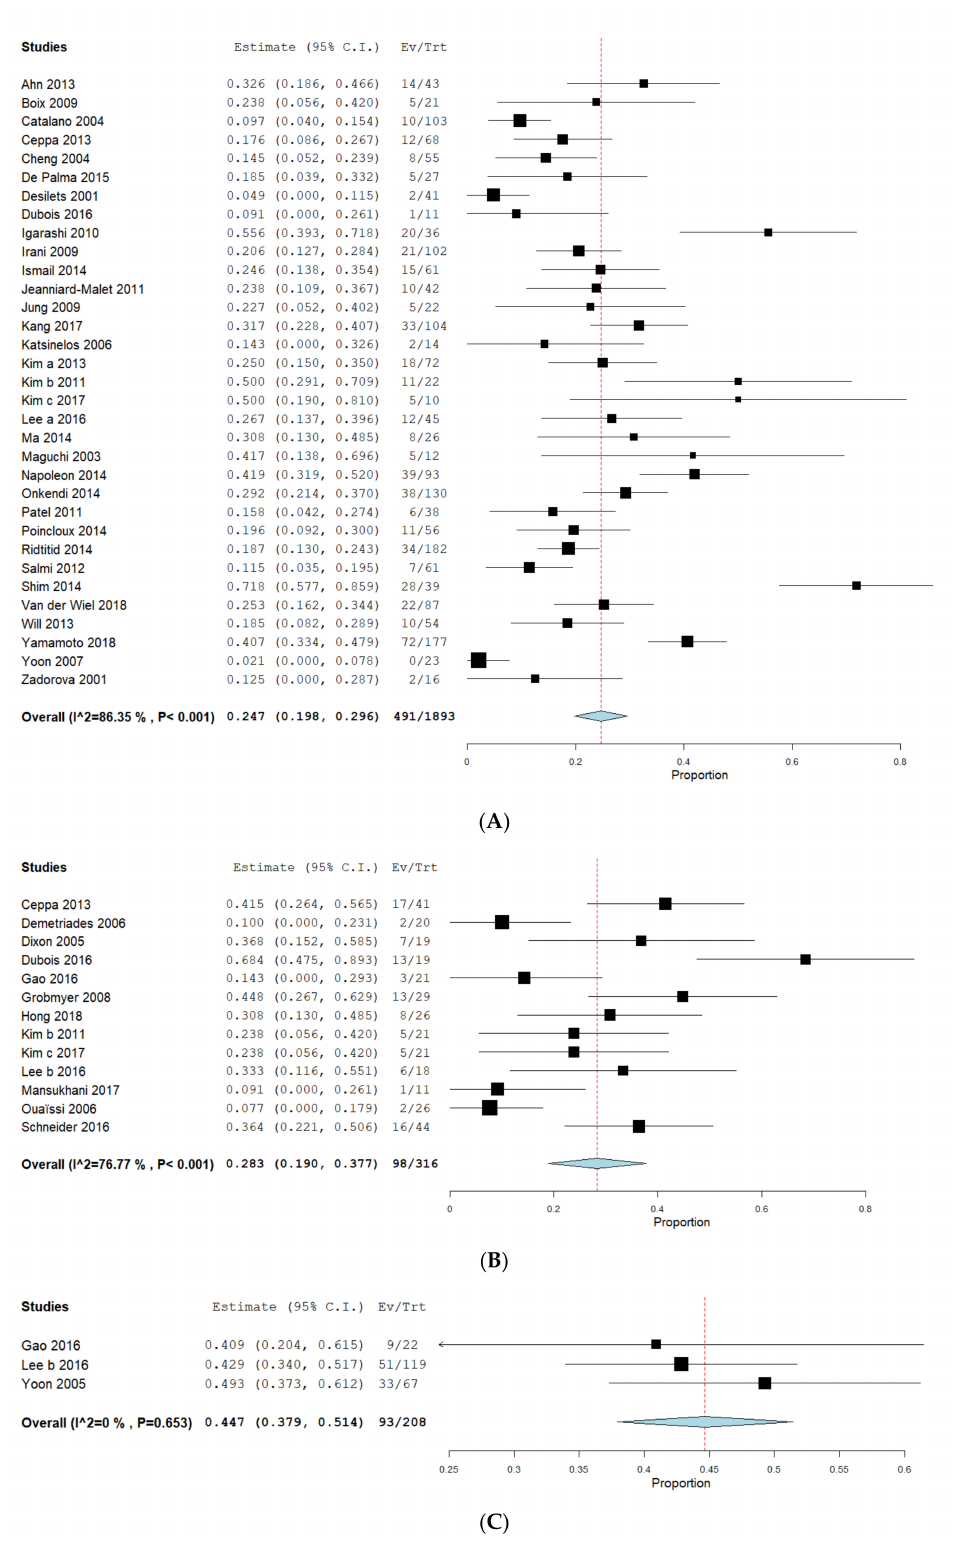
Figure 3. Complications in endoscopic and surgical intervention. Proportions of meta-analyses were calculated and shown as forrest-plot for EA ( A ), SA ( B ) and PD ( C ). Pooled rates of complications were calculated to obtain a proportion with a 95% confidence interval (CI). The binary random e ff ects model (DerSimonian–Laird) was used for EA and SA and a fixed e ff ect model with inverse variance weighting for PD. EA: endoscopic ampullectomy, SA: surgical ampullectomy, PD: pancreaticoduodenectomy, AP: acute pancreatitis, NA: not